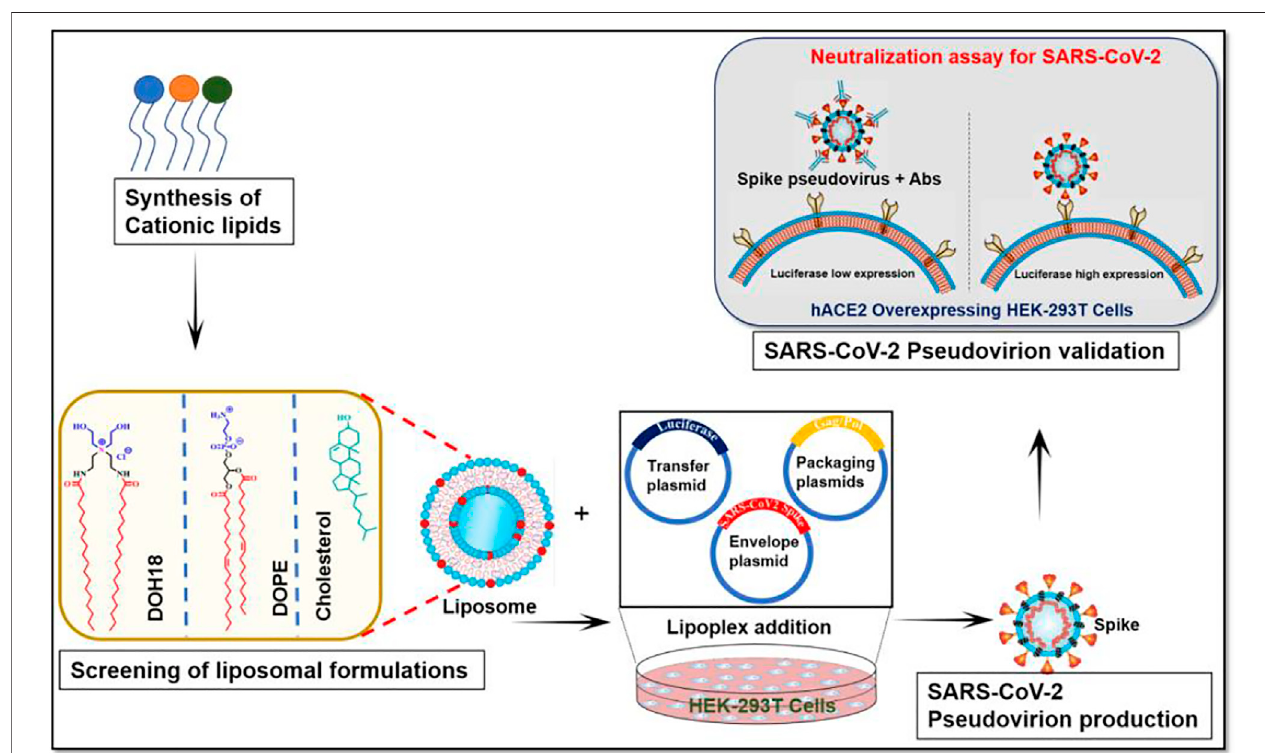
FIGURE 5 | Schematic presentation of the protocol that includes the steps involved in producing SARS-CoV-2 pseudovirion.